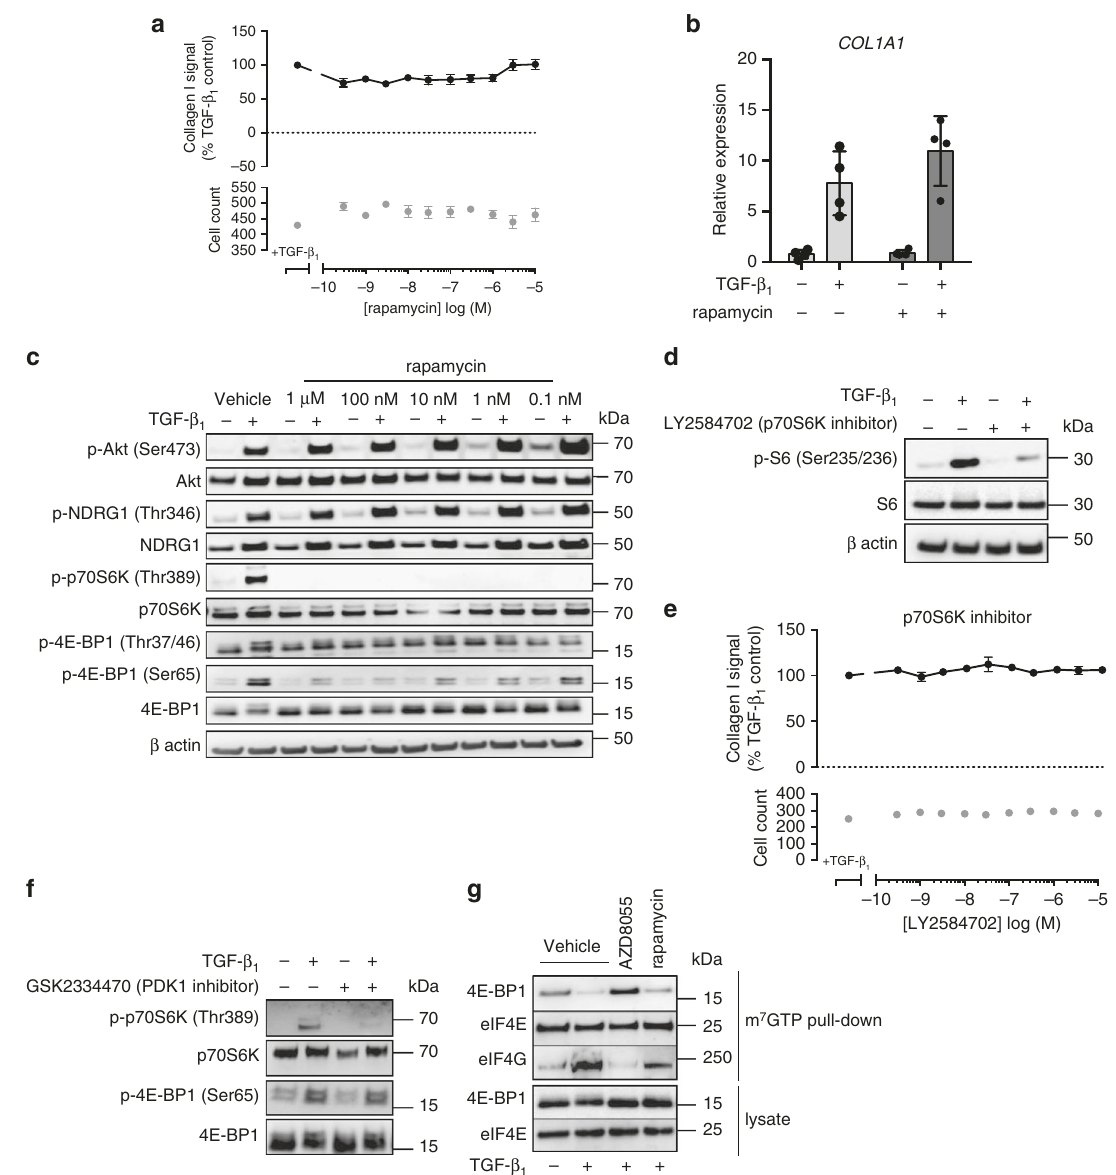
Fig. 5 Rapamycin-insensitive mTORC1 signaling mediates TGF- β 1 -induced collagen I deposition. pHLFs were pre-incubated with vehicle (0.1% DMSO) or increasing concentrations of rapamycin ( a ) and LY2584702 ( e ) and stimulated with TGF- β 1 for 72 h with collagen I deposition assessed by macromolecular crowding assay. Data are expressed as collagen I signal as a percentage of the TGF- β 1 -treated control ( n = 4 fi elds of view imaged per well) and cell counts obtained by staining nuclei with DAPI. Data are presented as mean ± SEM ( n = 4) and are representative of 3 independent experiments. Additionally, pHLFs were pre-incubated with vehicle (0.1% DMSO) or increasing concentrations of rapamycin ( c ), 1 µ M LY2584702 ( d ), or 1 µ M GSK2334470 ( f ) prior to stimulation with TGF- β 1 (1 ng/ml). Cells were lysed 12 h later and the phosphorylation of speci fi ed proteins was assessed by Western blot. COL1A1 mRNA levels were assessed by RT qPCR after pre-incubation of pHLFs with vehicle (0.1% DMSO) or 100 nM rapamycin prior to TGF- β 1 stimulation for 24 h ( b ). Relative expression was calculated using 2 − Δ Ct . Δ Ct was calculated from the geometric mean of two reference genes. Data are presented as mean ± SEM ( n = 4). Differences between groups were evaluated with two-way ANOVA. For immunoprecipitation of the m 7 GTP cap, pHLFs were pre- incubated with vehicle (0.1% DMSO), 1 µ M AZD8055 or 100 nM rapamycin prior to TGF- β 1 stimulation. Protein levels were assessed by Western blot ( g